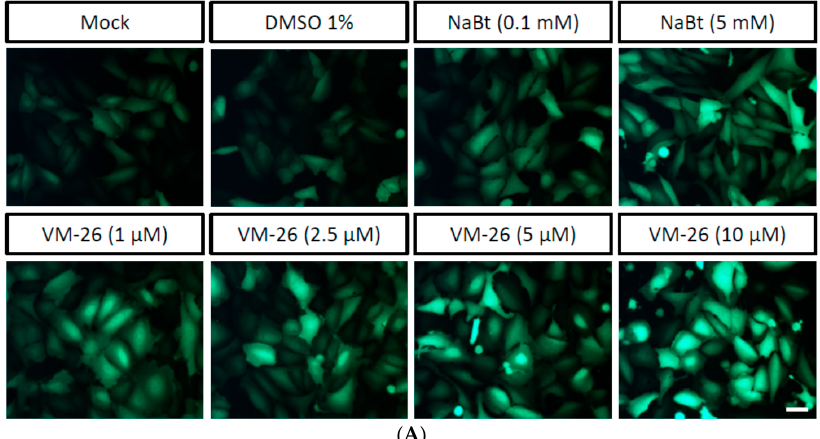
Figure 2. Cont. Figure 2.